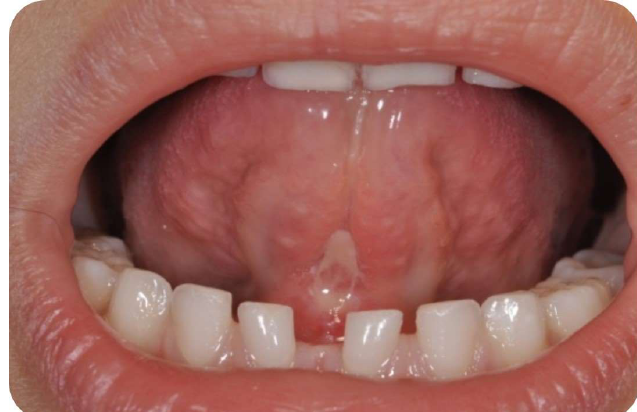
Figure 4. No bleeding or edema and good soft tissue healing after seven days.